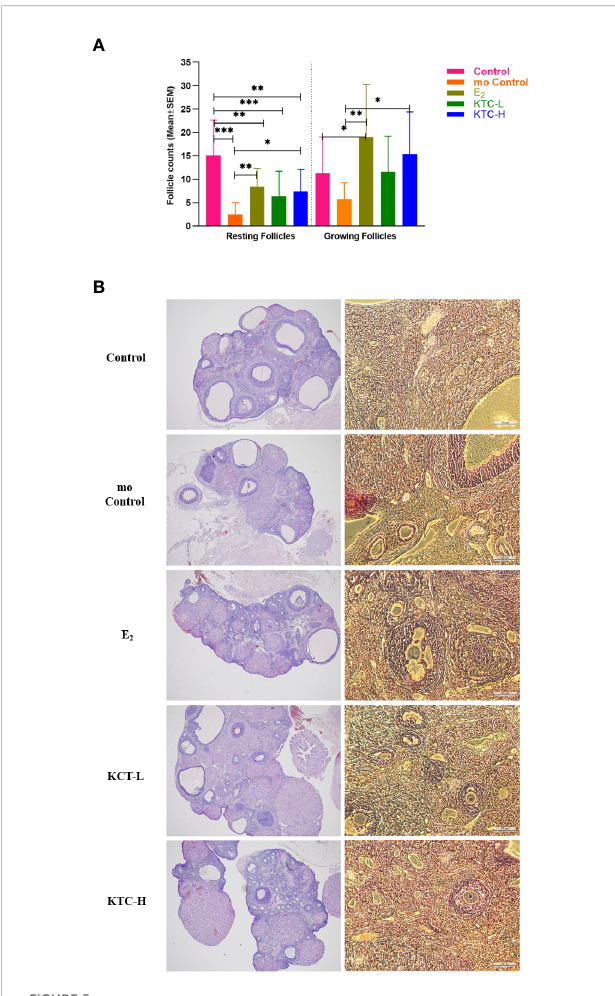
FIGURE 5 (A) The number of Resting and Growing follicles among the fi ve groups is compared. (B) Typical HE pictures of the fi ve groups. * P <0.05, ** P <0.01, *** P